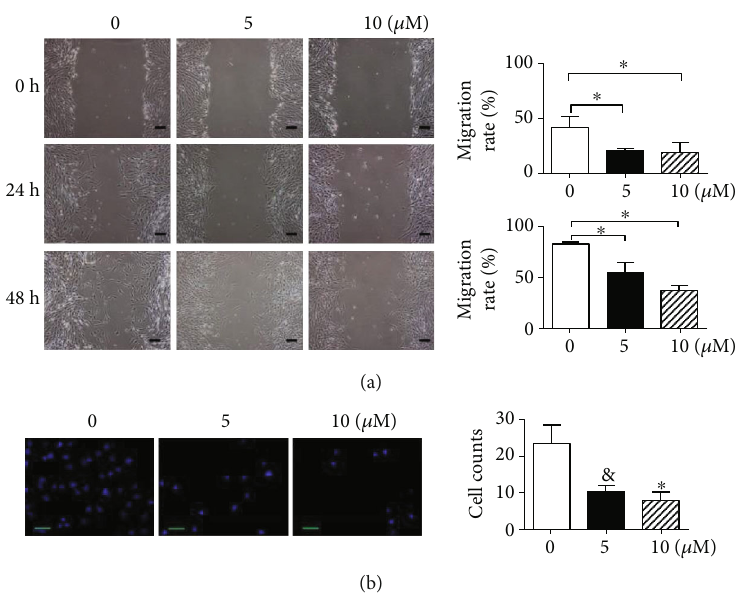
Figure 3: LY2109761 inhibits keloid-derived fi broblast migration and invasion. (a) Scratch experiments using increasing doses of LY2109761; representative images are shown on the left, and summarized results are shown on the right as the mean ± SEM from three independent experiments. (b) Invasion experiments at increasing doses of LY2109761; representative images are shown on the left, and summarized results are shown on the right as the mean ± SEM from three independent experiments. Scale bar = 50 μ m . ∗ P < 0 : 05 between LY2109761 groups and DMSO control; ∗∗ P < 0 : 05 between LY2109761 5 μ M and 10 μ M treatment groups.